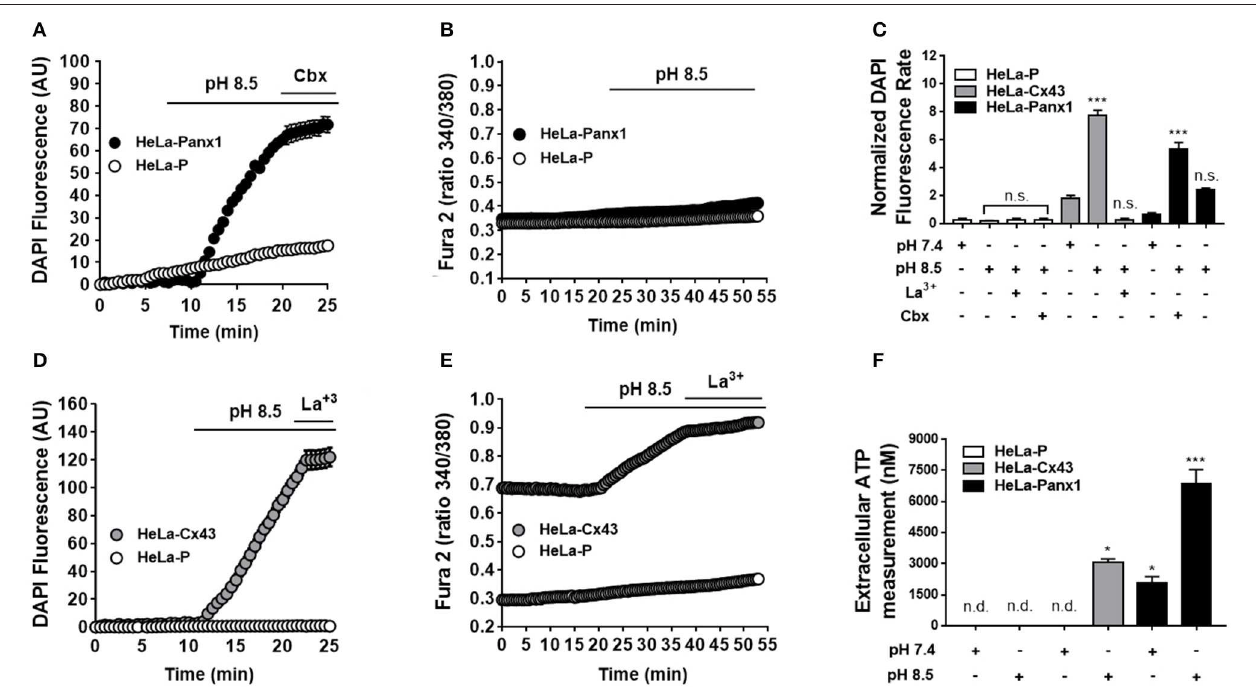
FIGURE 5 | Dye uptake but not Ca 2 + signal is increased by extracellular alkaline pH via Panx1 Chs. HeLa-Parental cells (HeLa-P) and HeLa cells transfected with Panx1 or Cx43 (HeLa-Panx1 and HeLa-Cx43 cells, respectively) were used to evaluate fluorescence intensity of DAPI (5 µ M) uptake (in arbitrary units: AU) and Ca 2 + signal (calcium imaging of Fura-2-loaded cells, ratio 340/380nm) was evaluated under different conditions. HeLa-Cx43 were used as positive controls. Opening of Panx1 or Cx43 channels was induced by exposure to alkaline (pH 8.5) solution. During the last 5min of recording, cells were treated with 5 µ M carbenoxolone (Cbx) or 200 µ M lanthanum ions (La 3 + ) to inhibit Panx1 Chs or Cx43 HCs, respectively. Graphs (A,C) show representative time-lapse experiments of dye uptake. Graphs (B,D) show representative experiments of Ca 2 + signal over time under basal conditions and after exposure to extracellular alkaline solution (pH 8.5), in HeLa Cx43 and Panx1, respectively. Each plotted value represents the mean ± SEM. (between 30 and 50 cells were recorded in each experiment). (E) Quantification of normalized DAPI fluorescence rate (AU/min) in HeLa parental (white bars, n = 3), -Cx43 (gray bars, n = 5), and Panx1 cells (black bars, n = 5) at pH 7.4 and pH 8.5 bathing solution. (F) Measurement of ATP content in the supernatant of HeLa parental (white bars, n = 3), -Cx43 (gray bars, n = 3), and Panx1 cells (black bars, n = 9) after 10min of control and pH 8.5 bathing solution. In some cases, signal was not detectable (n.d.). *** p < 0.0005; * p < 0.05; no significance (n.s.) p >